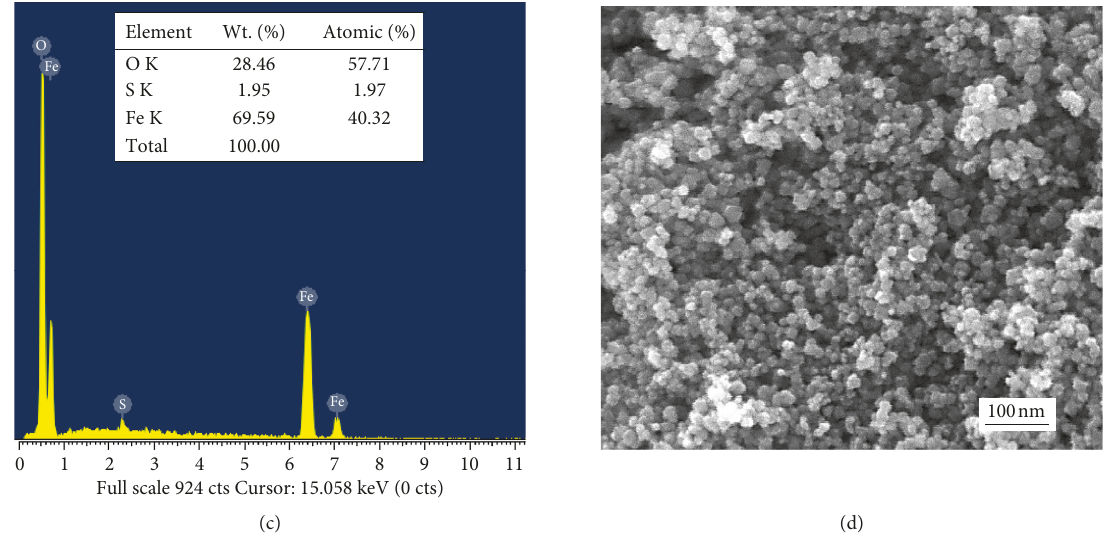
Figure 5: (a) FTIR of Fe 3 O 4 samples after exposing to SO 2 gas at the particular time; (b) SO 2 adsorption on Fe 3 O 4 samples; (c) SEM-EDX spectra; (d) FE-SEM image of Fe 3 O 4 after 60min of exposure to SO 2 . Inset in Figure 5(b) shows the XRD pattern of Fe 3 O 4 after 60min of exposure to SO 2